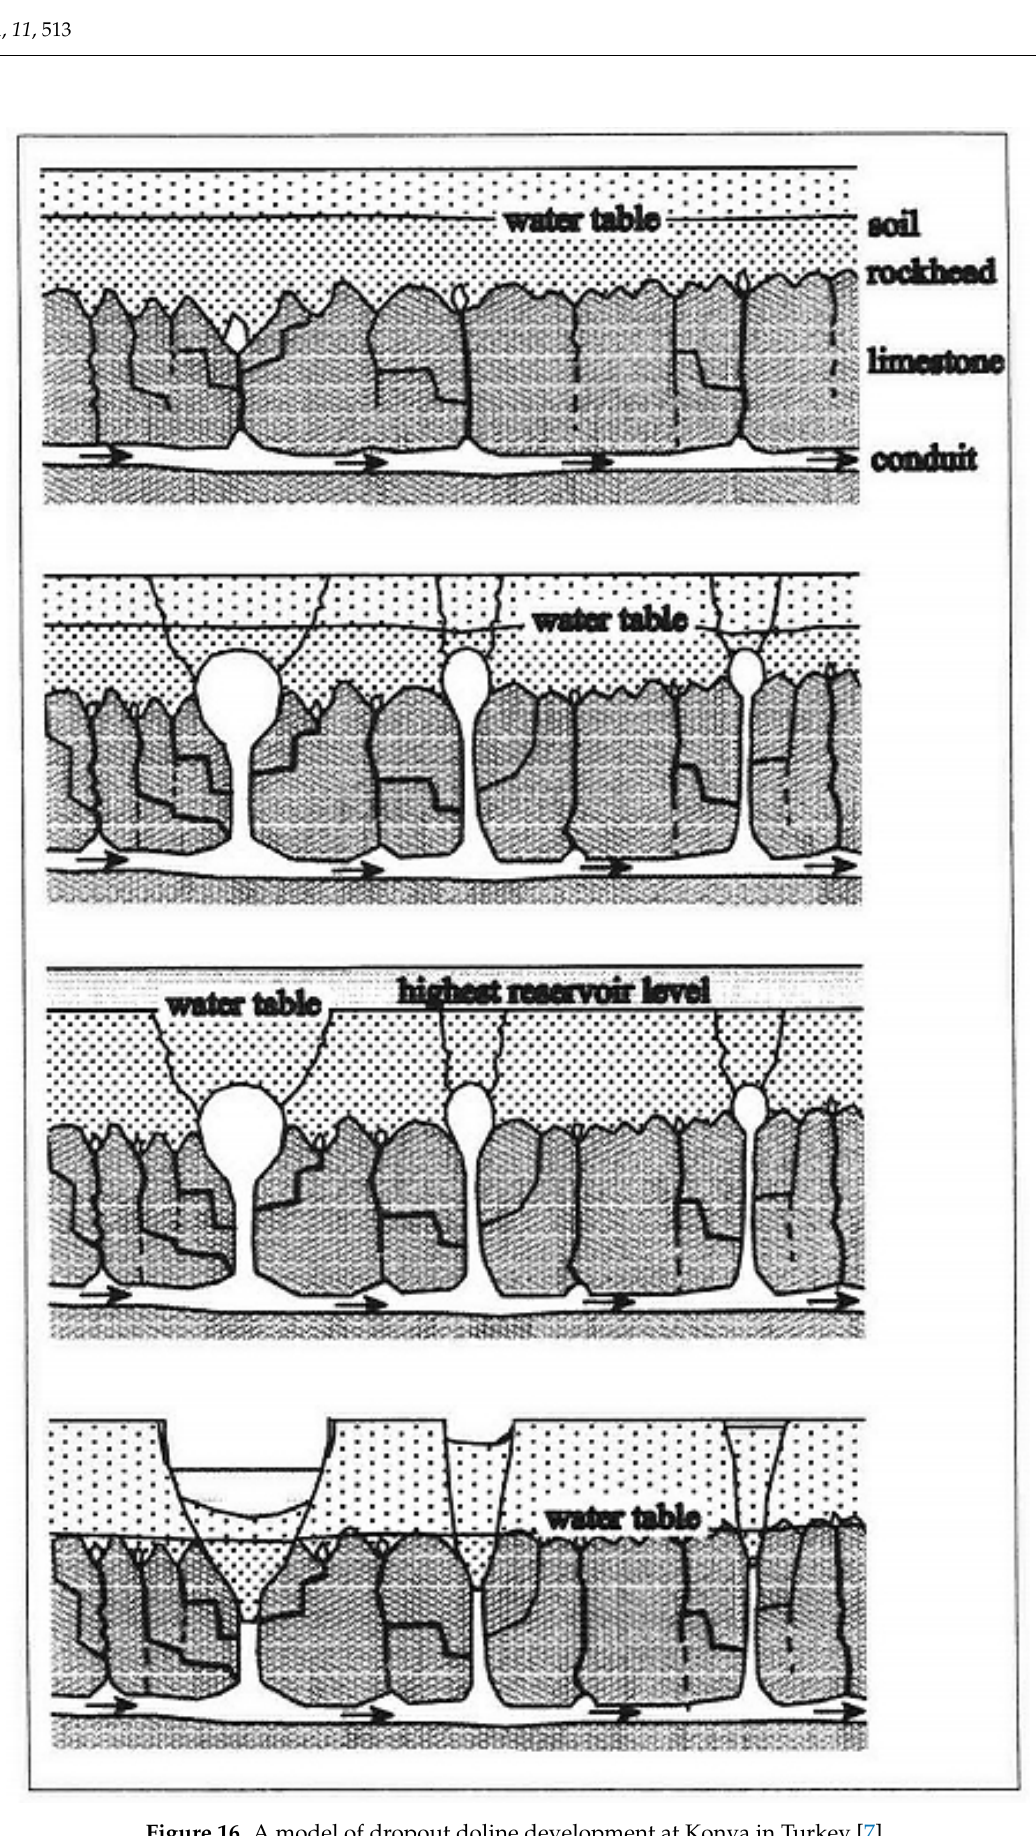
Figure 16. A model of dropout doline development at Konya in Turkey [7].